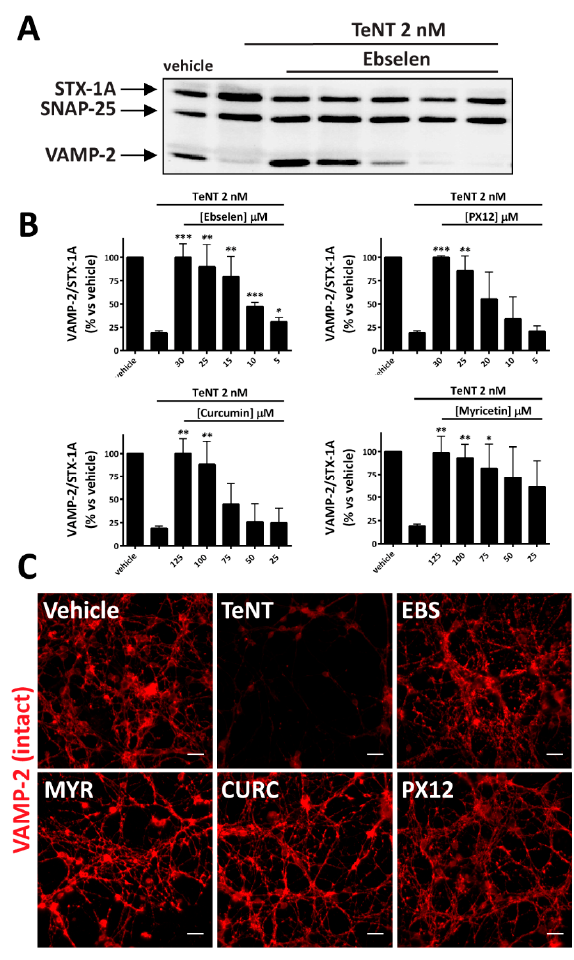
Figure 1. Thioredoxin Reductase–Thioredoxin (TrxR–Trx) inhibitors prevent TeNT cleavage of VAMP-2 in cultured neurons. CGNs were incubated with the indicated concentration of